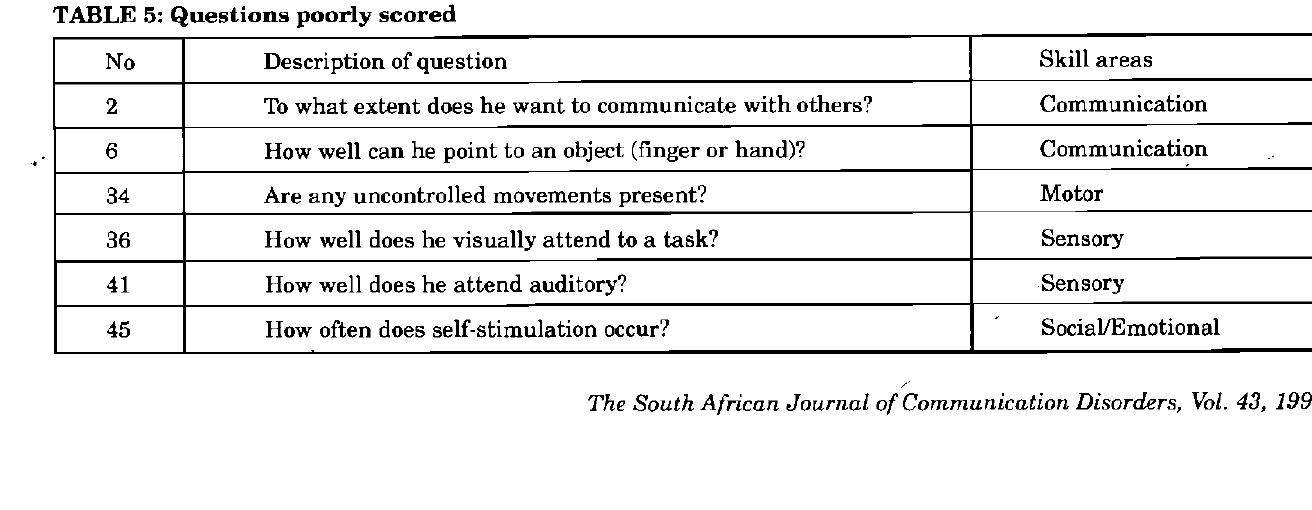
TABLE 5: Questions poorly scored